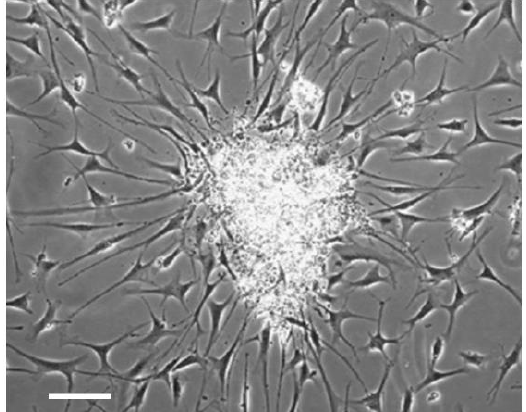
Figure 3. Primary culture of cells from PNET biopsies generates neurospheres with differentiating cells. The cells that give rise to neurospheres are CSCs. Scale bar = 100 μ m.